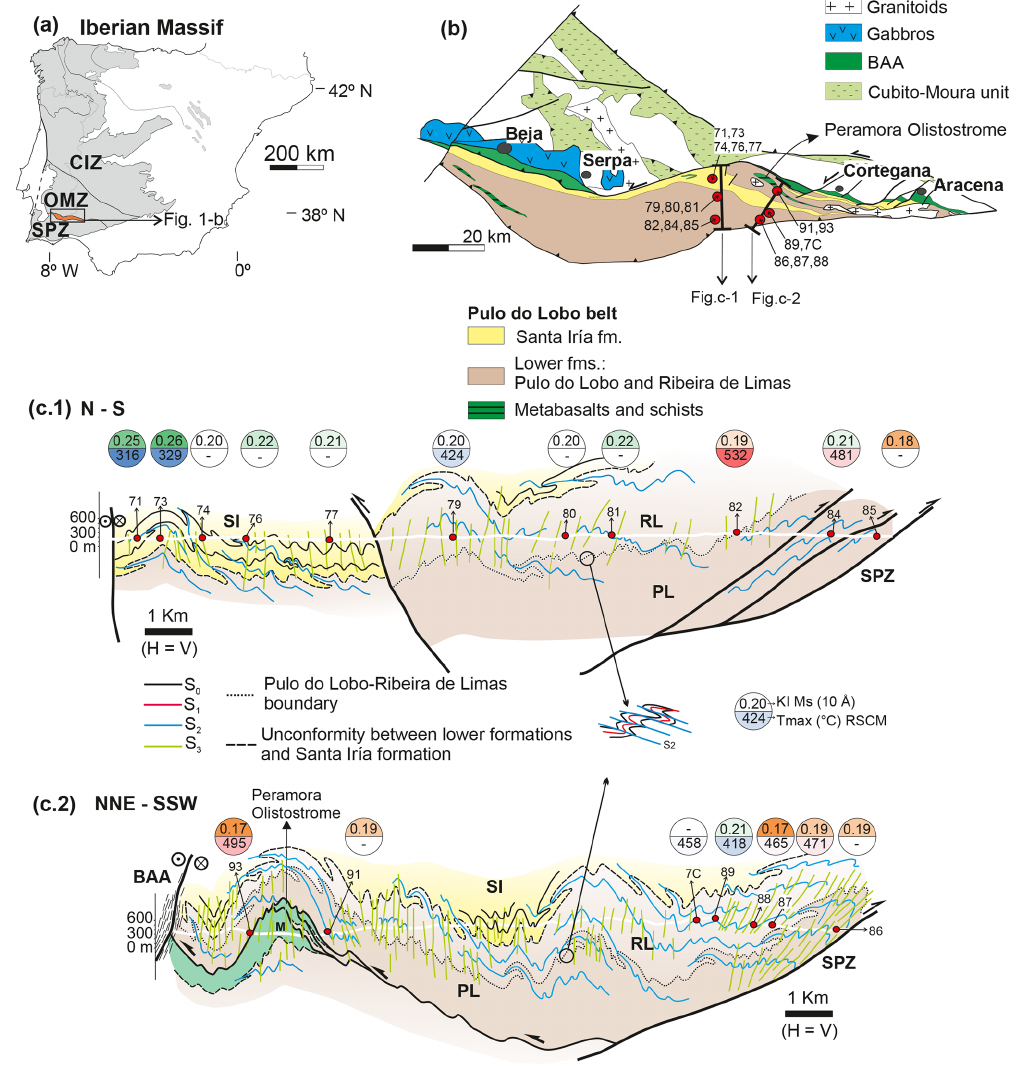
Figure 1. (a) Location of the studied area in the SW of the Iberian Massif (in grey). CIZ: Central Iberian Zone, OMZ: Ossa-Morena Zone, SPZ: South Portuguese Zone. (b) Geological map of the Pulo do Lobo domain and other units related to the OMZ–SPZ boundary with indications of the two cross sections studied and the samples collected. (c1–2) Geological cross sections of the Pulo do Lobo domain (see b for location) (modified from Martínez Poza et al., 2012; Pérez-Cáceres et al., 2015). Numbered red circles in (b) – (c) locate the samples studied. Big circles show the KI values for 10Å reflection peaks of K-white mica and the average RSCM temperatures, with the relative color bar according to the results shown in Table 1. BAA: Beja–Acebuches Amphibolites, M: metabasalts, PL: Pulo do Lobo Formation, RL: Ribeira de Limas Formation, SI: Santa Iría